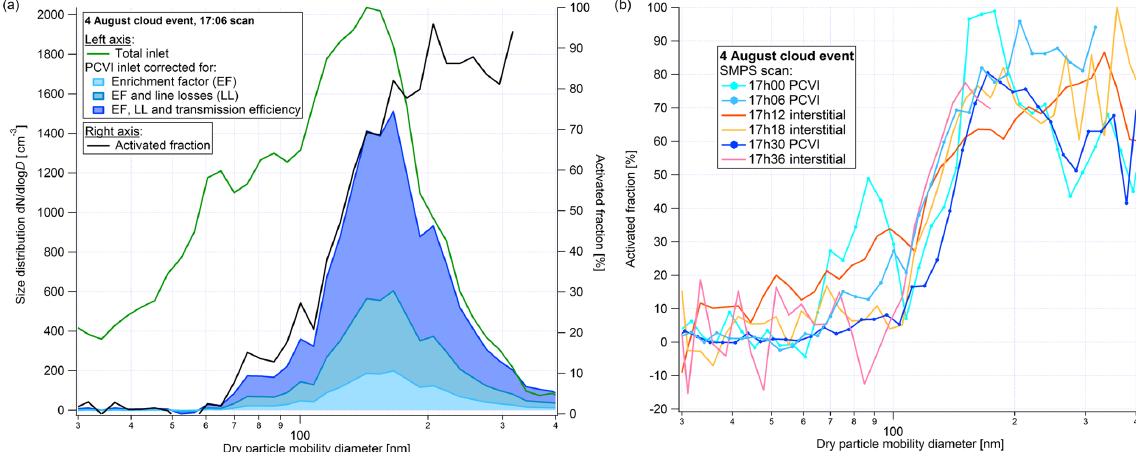
Figure 3. Cloud droplet residual particle measurements using the PCVI inlet for the example of the 4 August cloud event. (a) Particle number size distributions measured behind the total and PCVI inlets and corresponding activated fraction (Eq. 2). The corrections applied to the PCVI data are illustrated with the blue shadings. (b) Comparison between PCVI-derived and interstitial-derived activated particle fractions.